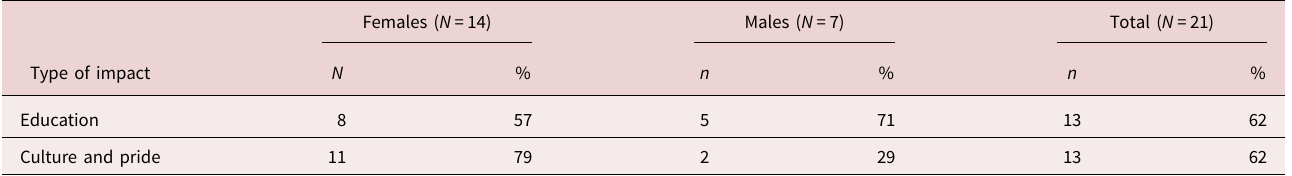
Table 1. Responses of impacted student participants ( N =21) from the original BMG study (adapted from Louth,